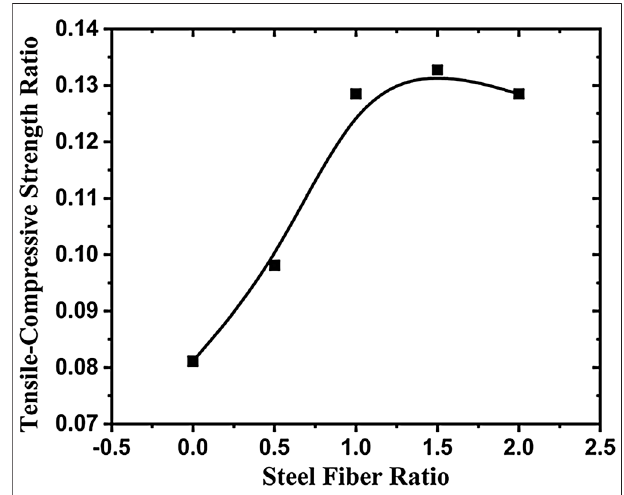
FIGURE6| The relationship betweentensile-compressive strength ratio of CGCLWAC and steel fi ber content.